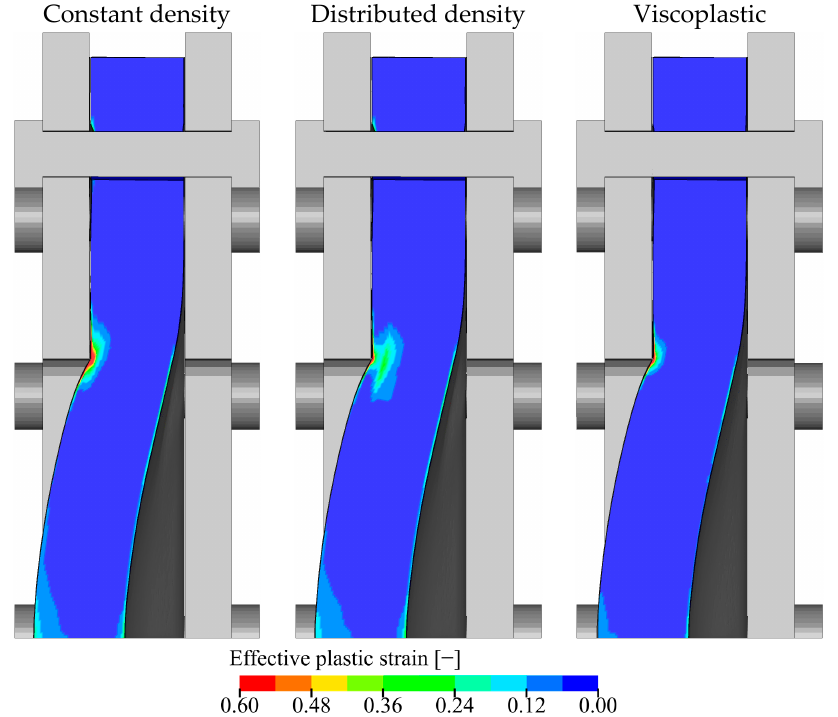
Figure 24. Deformation profiles and plastic strain fields from numerical simulations of test Sw_700_P10.